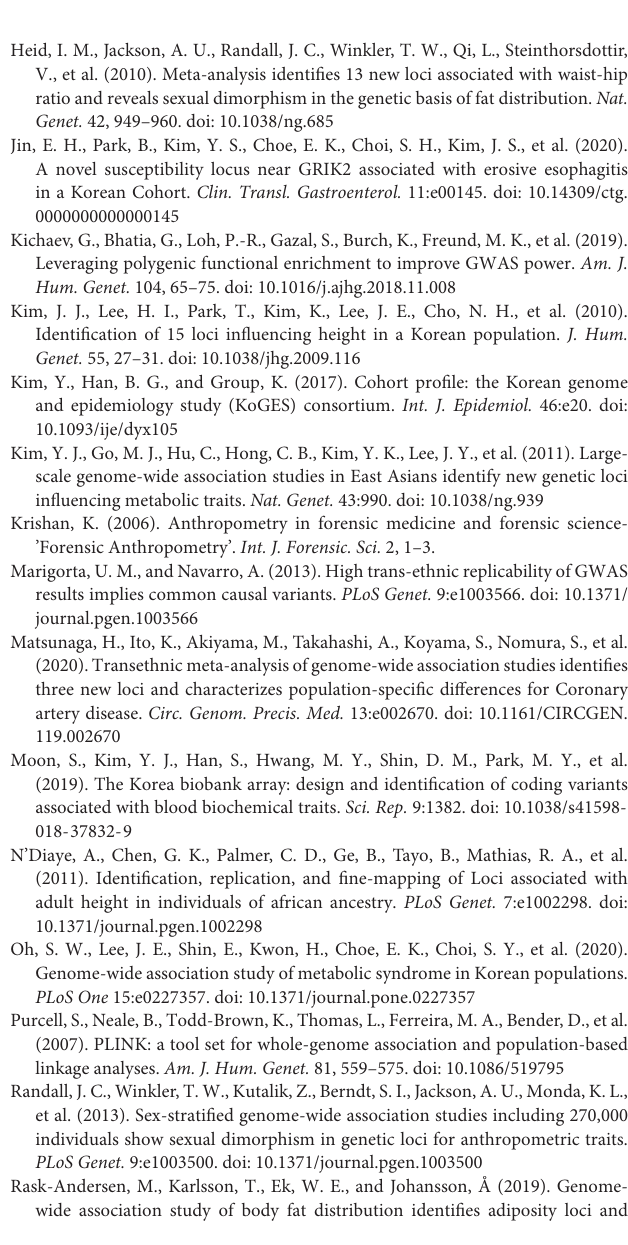
Supplementary Figure 1 | Manhattan plot showing a genome-wide association between height and women in the discovery stage. The red line suggests that the genome-wide significance level was of p -value < 10 − 5 in the discovery stage. Supplementary Figure 2 | Expression of each genotype of (A) rs6457765, (B) rs147736074, and (C) rs13201774 in the C6orf106 region of the skeletal muscle. Supplementary Figure 3 | Gender-based gene expression of CUX2 . Supplementary Table 1 | Identified independent signals at a previously reported gene with genome-wide significant associations. Supplementary Table 2 | Significant single tissue eQTL results for nine novel genetic variants and signals belonging to C6orf106 using the GTEx portal. Supplementary Table 3 | Replication of 19 previously discovered loci in our study